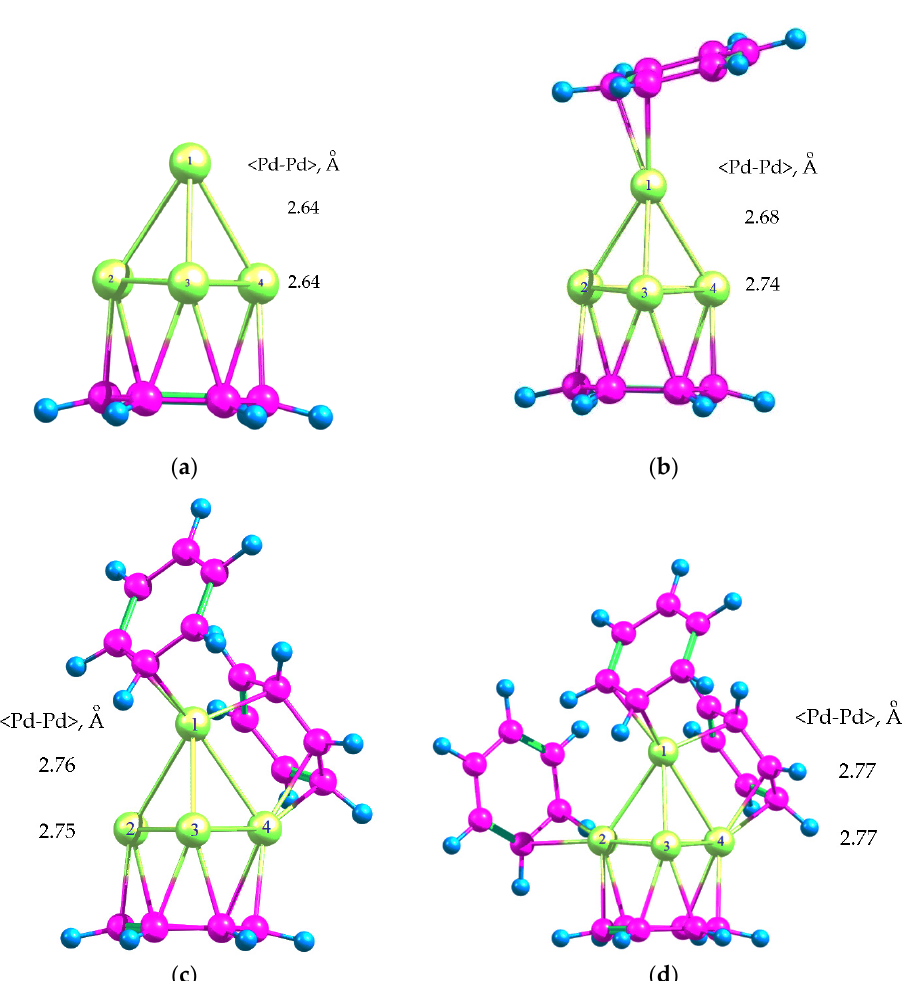
Figure 2. Optimized geometries of Pd-BZ adsorption complexes: Pd 4 *C 6 H 6 ( a ), Pd 4 *2C 6 H 6 ( b ), Pd 4 *3C 6 H 6 ( c ) and Pd 4 *4C 6 H 6 ( d ).